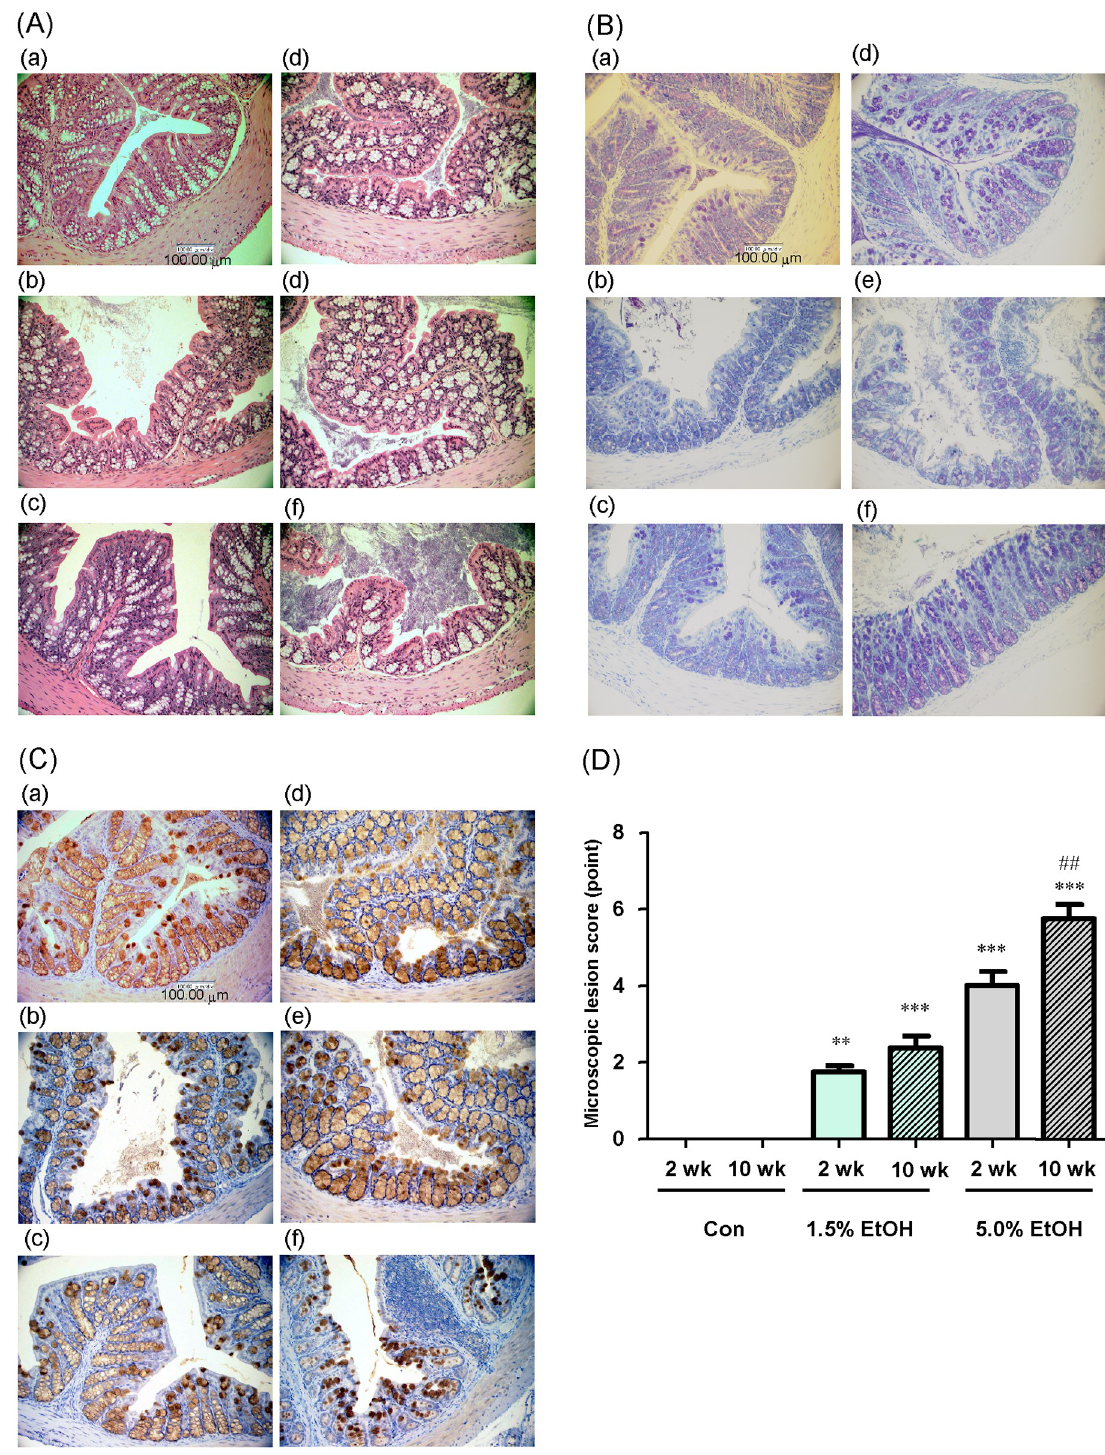
Fig 2. Microscopic observation of colonic mucosa and evaluation of colonic lesions formed with chronic oral administration of ethanol in mice. Eight-week-old mice were orally gavaged daily with 1.0 mL/day of water (Con), 1.0 mL/day of 1.5% (v/v) ethanol (1.5% EtOH), or 1.0 mL/day of 5.0% (v/v) ethanol (5.0% EtOH) for 10 weeks. At weeks 2 and 10 (2 wk and 10 wk, respectively), representative colonic tissue sections were observed microscopically. (A) HE staining images at 400X magnification, (B) TB staining images at 400X